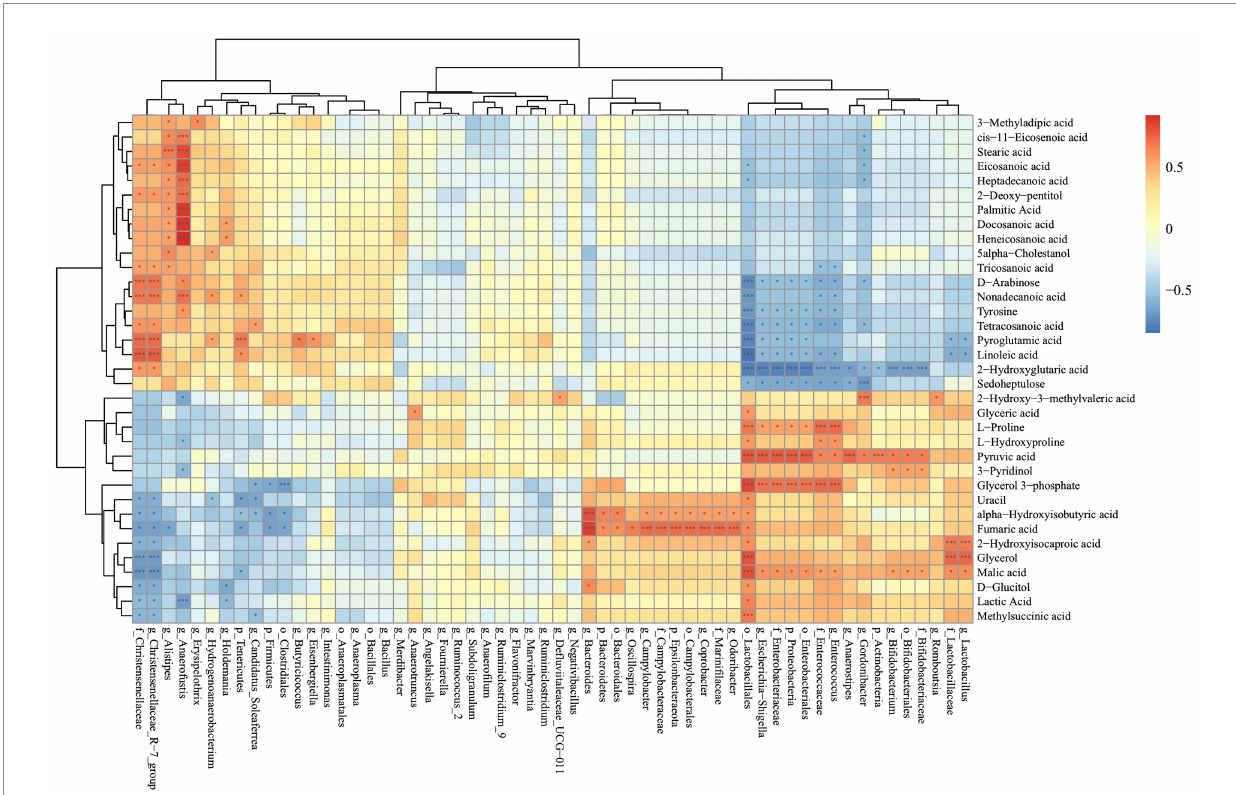
FIGURE 10 Correlations between significantly altered cecal metabolites and the bacterial strains between the BS-treated and SNE group. * p > 0.01 and p < 0.05, *** p < 0.01. SEM, standard error of mean. Each value represents the mean ± SEM of 7 replicates ( n =